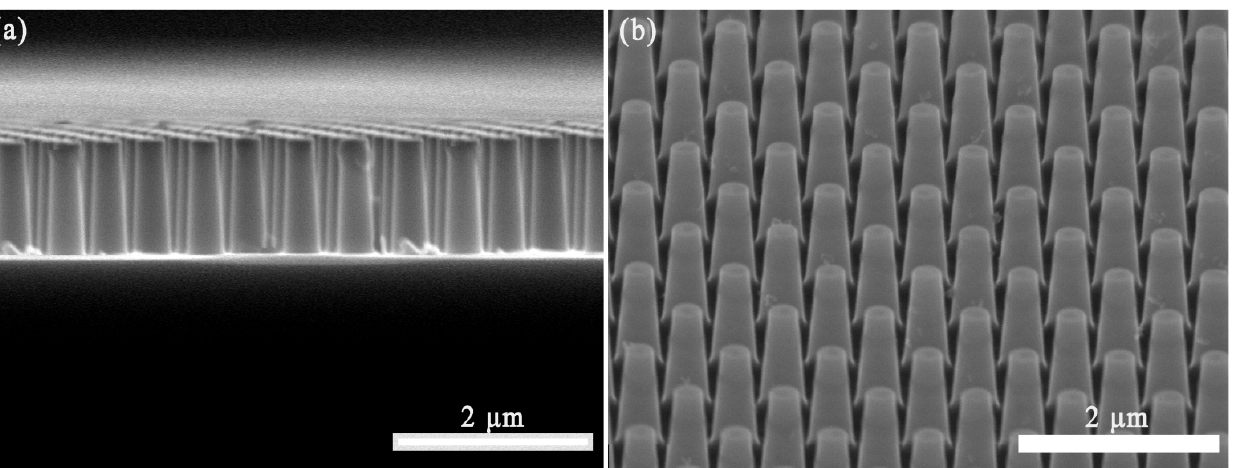
Figure 2. ( a ) Cross section and ( b ) top view SEM images of Si NTCAs.